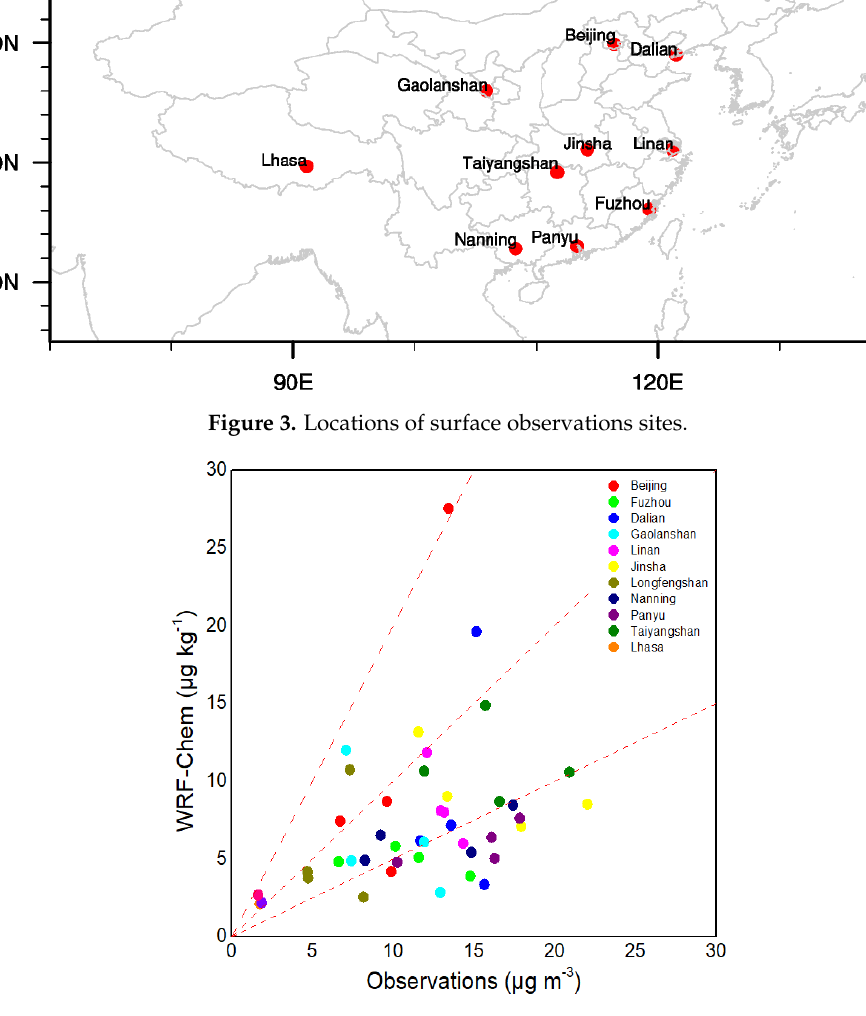
Figure 4. Comparisons between simulated sulfate aerosol seasonal average concentrations from Weather Research and Forecasting model coupled with Chemistry (WRF-Chem) ( µ g kg − 1 ) with that of surface observations ( µ g m − 3 ) (the dashed lines indicate 2:1, 1:1, and 1:2 relationships from top to bottom, respectively).